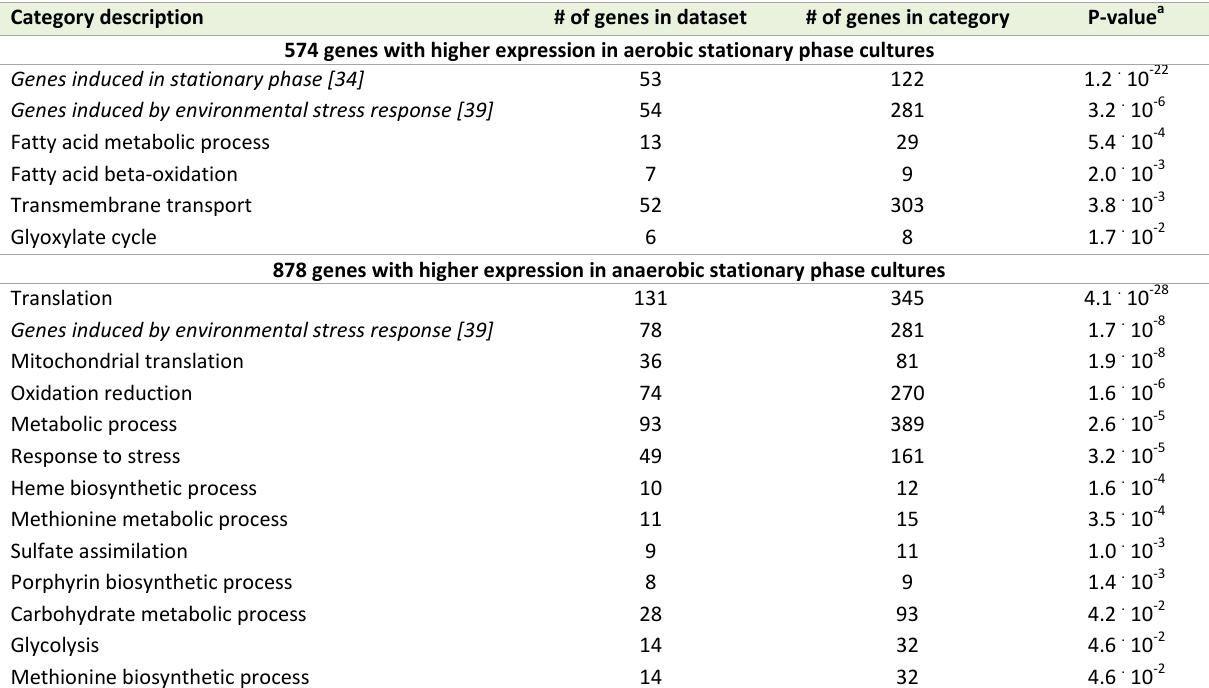
TABLE 1. Functional categories overrepresented among genes with different expression levels in aerobic and anaerobic stationary phase